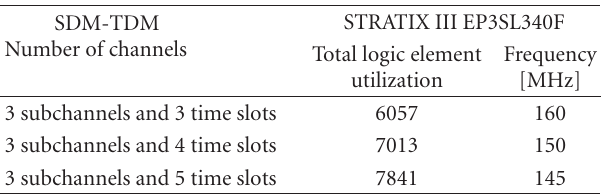
Table 5: Synthesis results SDM-TDM router (3 SC, 3, 4, 5 TS).